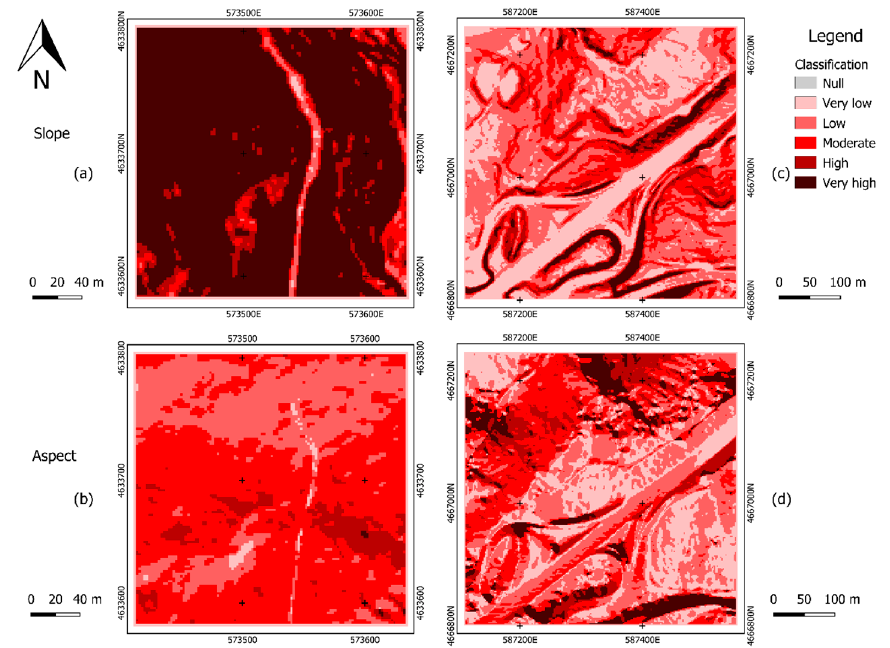
Figure 8. Classification of slope (first row) and aspect maps (second row). ( a ) Slope map classified of the study area A; ( b ) aspect map classified of the study area A; ( c ) slope map classified of the study area B; ( d ) aspect map classified of the study area B. The map coordinate system is EPSG:25829 ETRS89 / UTM zone